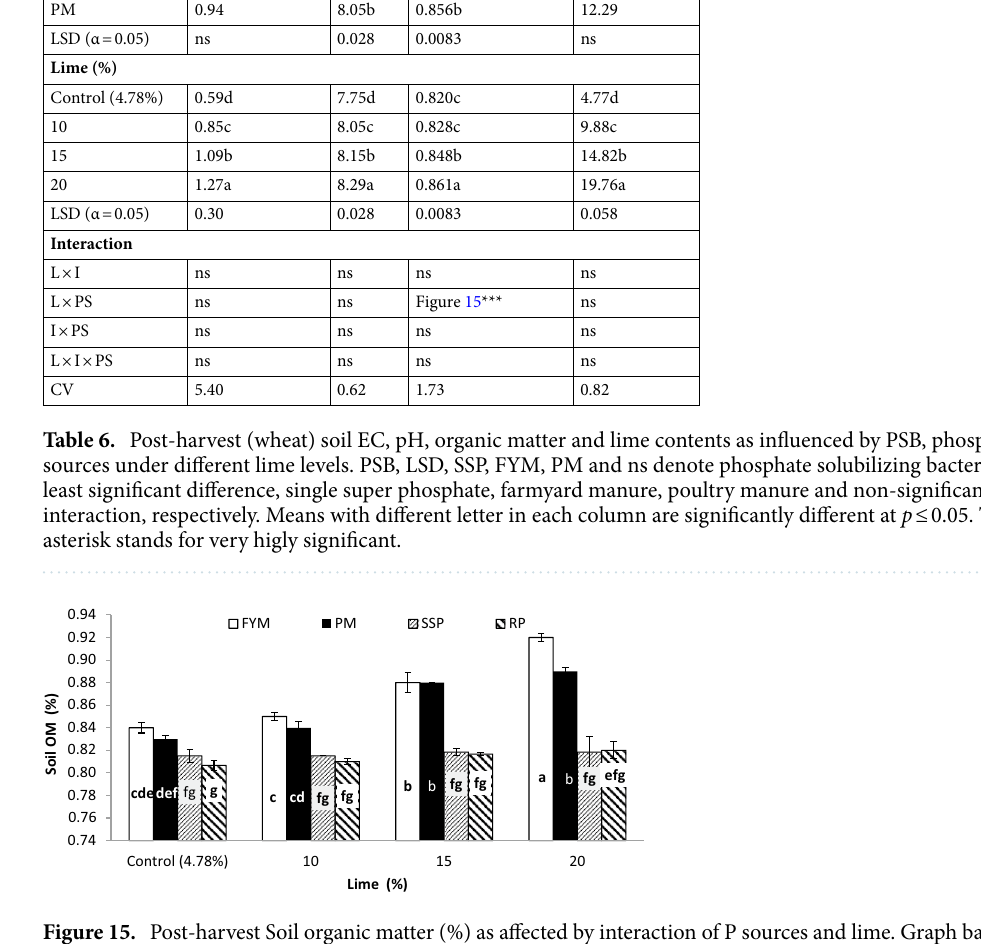
Figure 15. Post-harvest Soil organic matter (%) as affected by interaction of P sources and lime. Graph bars having different letters are significantly different at α = 0.05. Errors bar represent standard error for the mean of three